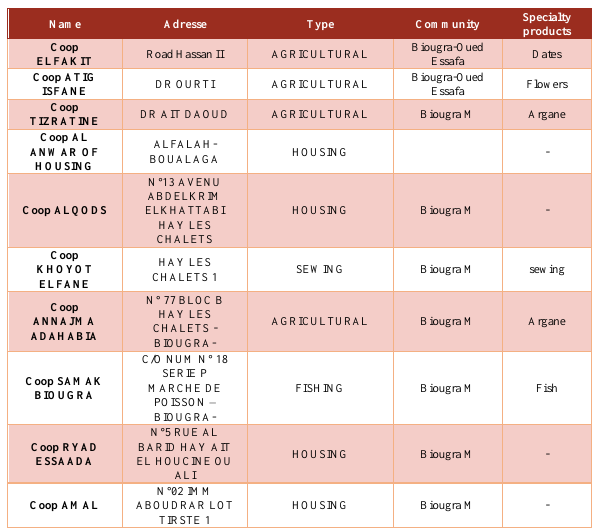
Table 1 . List of cooperatives in Biougra city The map below reveals the result of the cooperative's locations by using GPS coordinates.